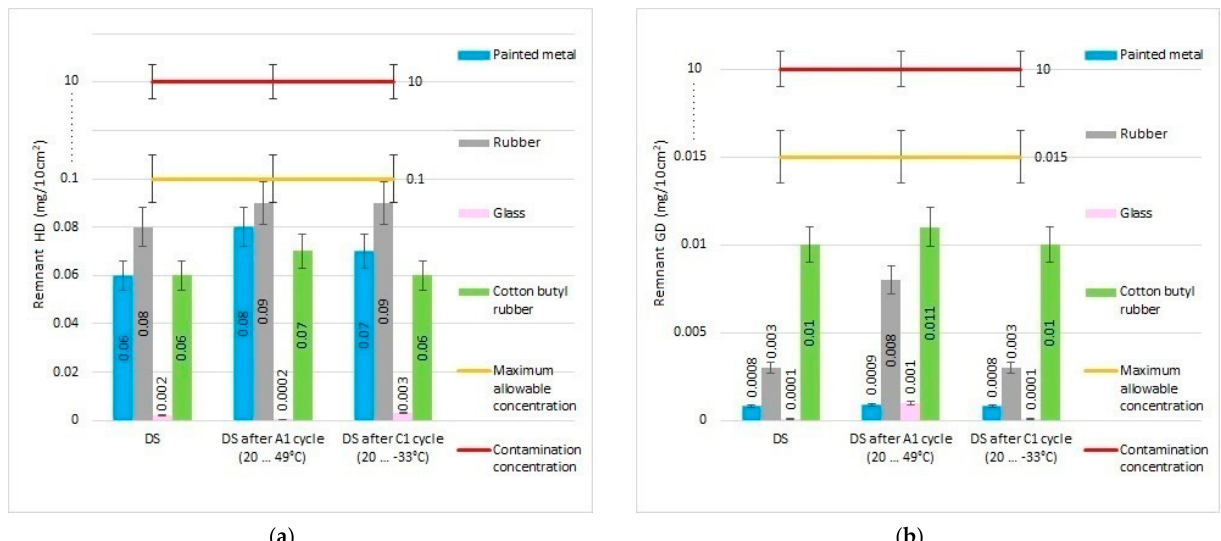
Figure 8. Remnant toxic concentrations ( a ) HD and ( b ) GD after decontamination with neat DS on different types of surfaces.